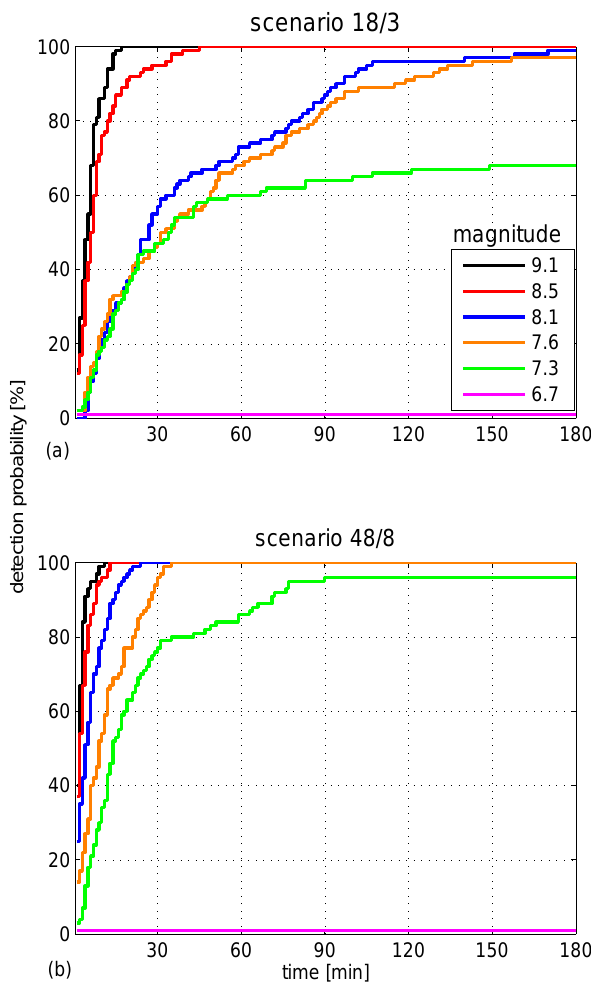
Fig. 9. Detection probability plots for six historical tsunamis in the Indian Ocean (Table 2) triggered by earthquakes with different mag- nitudes when detected by (a) a 18/3 GNSS-R Walker constellation and (b) a 48/8 GNSS-R Walker constellation at 900km with 60 ◦ inclination